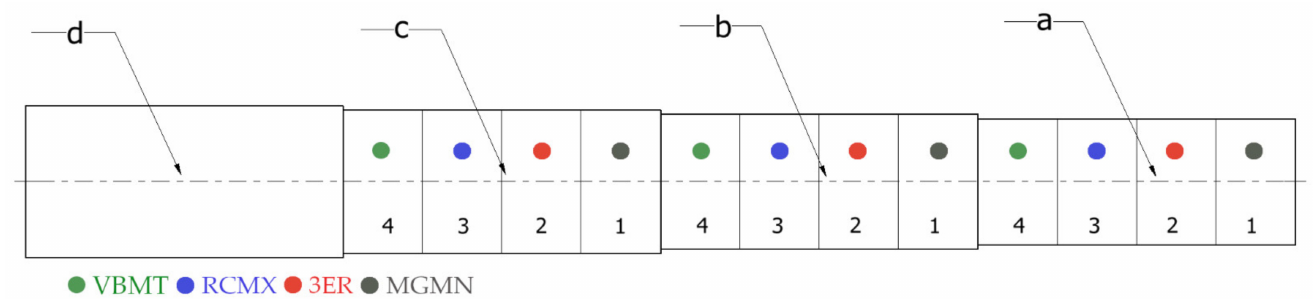
Figure 3. The specimen machining depth and tools zone ( a ) with 1.5 mm cutting depth; ( b ) with 1.0 mm cutting depth; ( c ) with 0.5 mm cutting depth; and ( d ) the unprocessed part reserved for clamping. Grooving insert ( 1 ), threadcutting insert ( 2 ), round insert ( 3 ), and pointed straight insert ( 4 ).